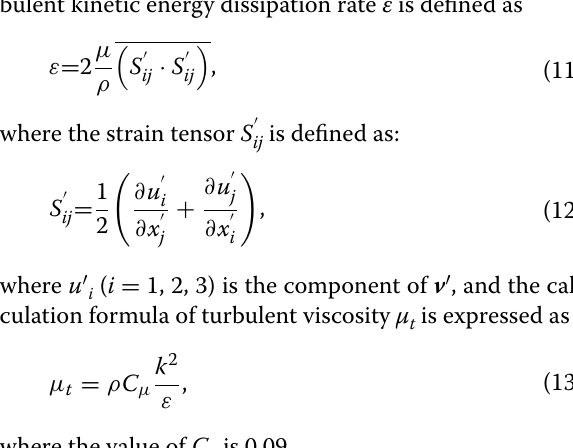
Table 1 Parameters for the CFD model Description Value Unit Pitch circle radius of piston bores